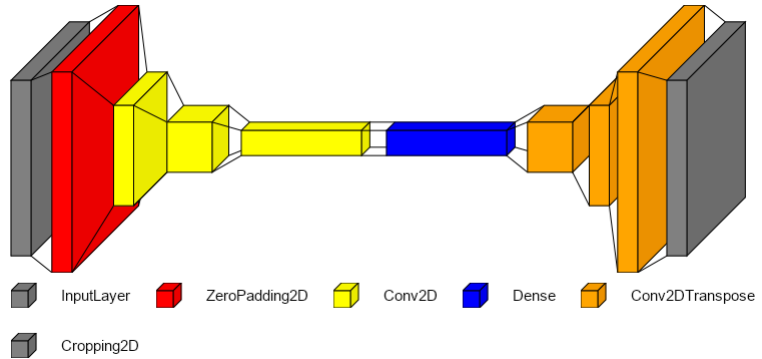
Figure 3. Architecture of a Convolutional Autoencoder ( CA c